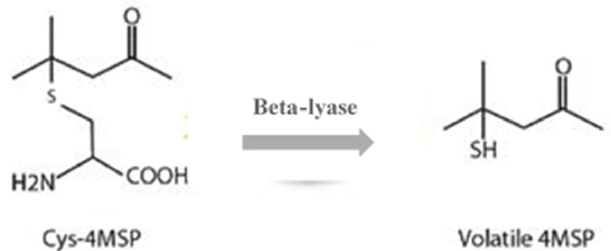
Figure 3. In this example, 4-methyl-4-sulfanylpentan-2-one (4-MSP) and cysteine are released from a nonaromatic cysteinylated precursor; modi fi ed from [28].